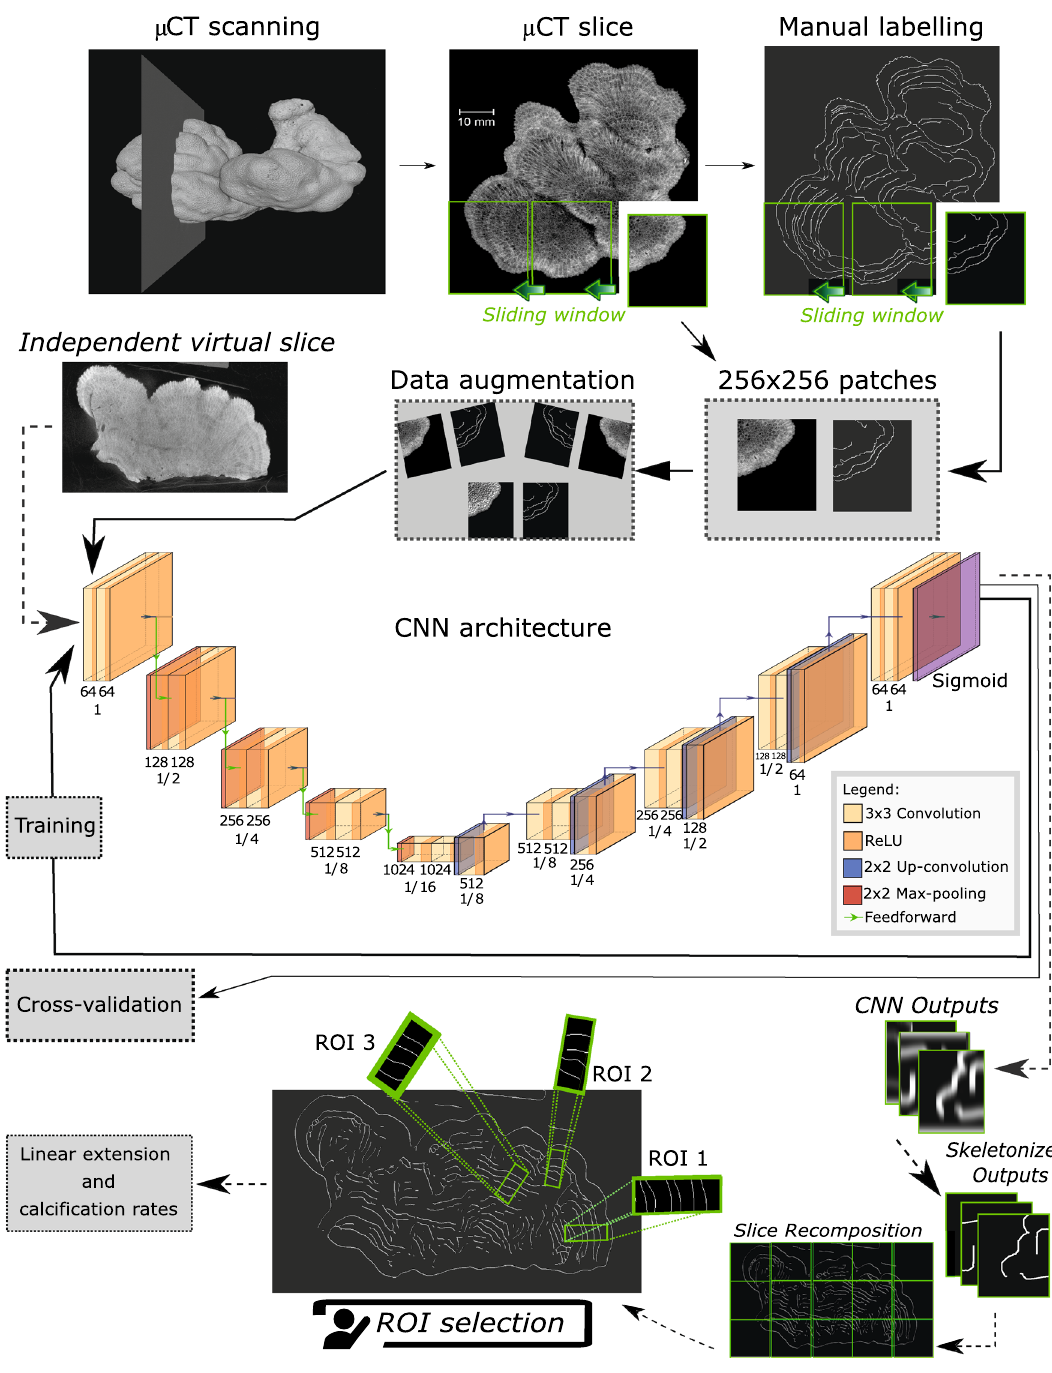
pixels correspond to higher density skeletal material) which is man- ually labelled by an expert and both the 2D slice and the labels are broken into small 256 × 256-pixel patches via a sliding window to then be used for training. Corresponding slice patches and manual patches are augmented the same way before entering the training loop (see SI for